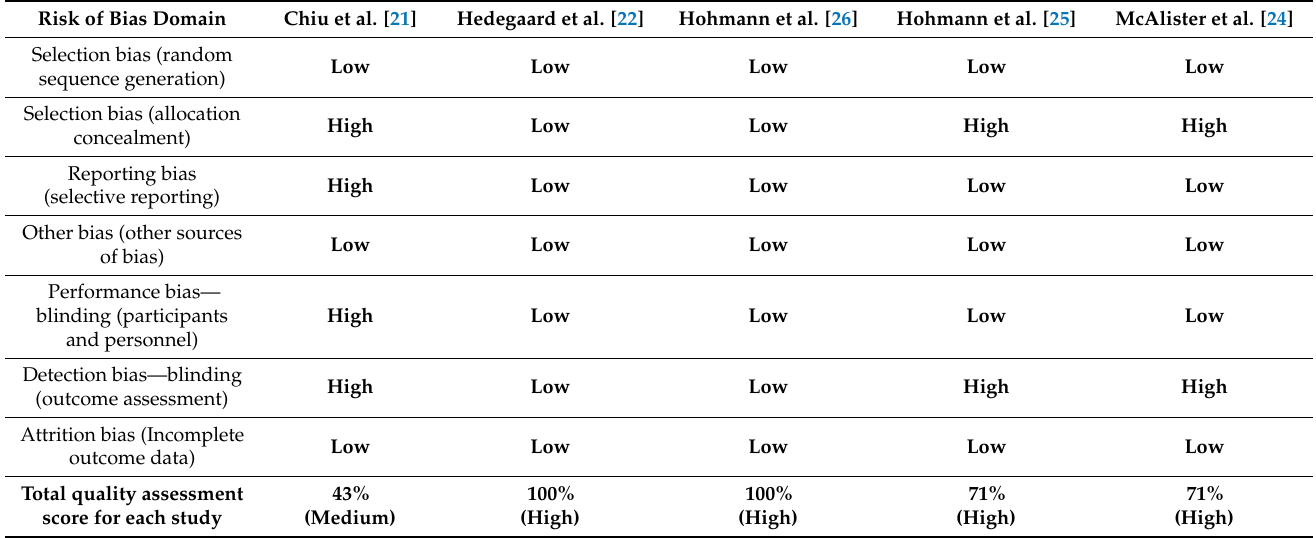
Table 1. Assessment of the Cochrane Risk of Bias for the included Randomized Controlled Trials (RCTs).